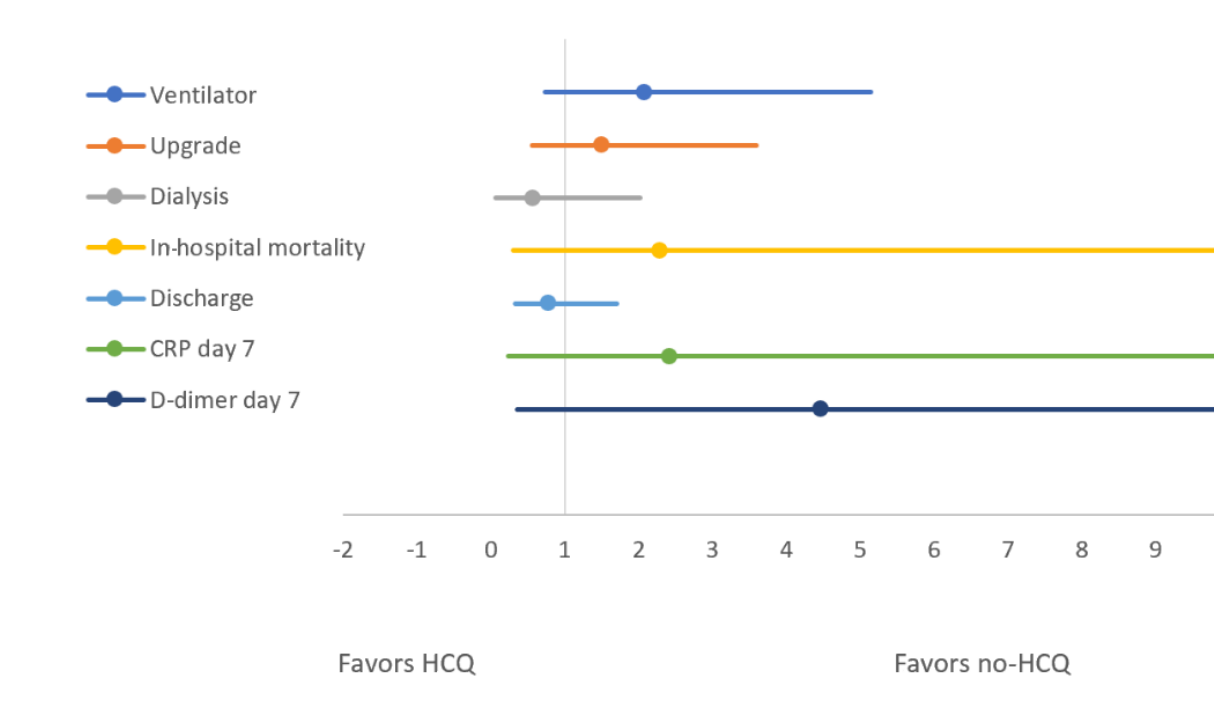
Figure 4. Forest plot comparing unadjusted odds of outcomes between the hydroxychloroquine (HCQ) and no-HCQ groups. CRP: C-reactive protein.